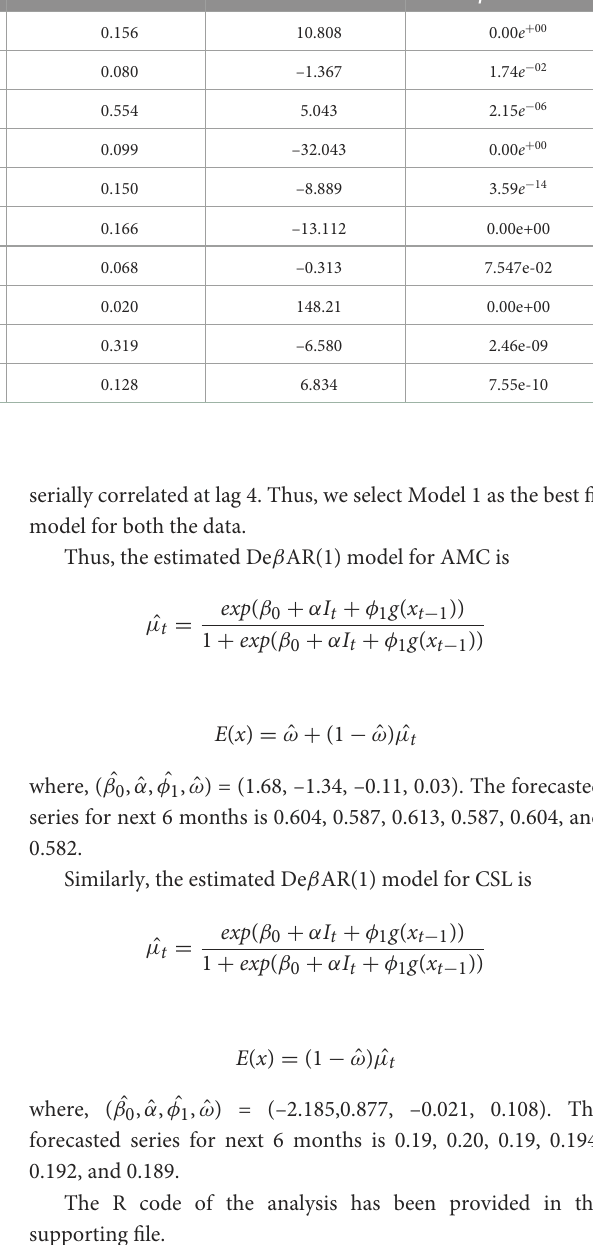
TABLE 3 Fitted De β AR model for rate of E. coli resistant to AMC and CSL.